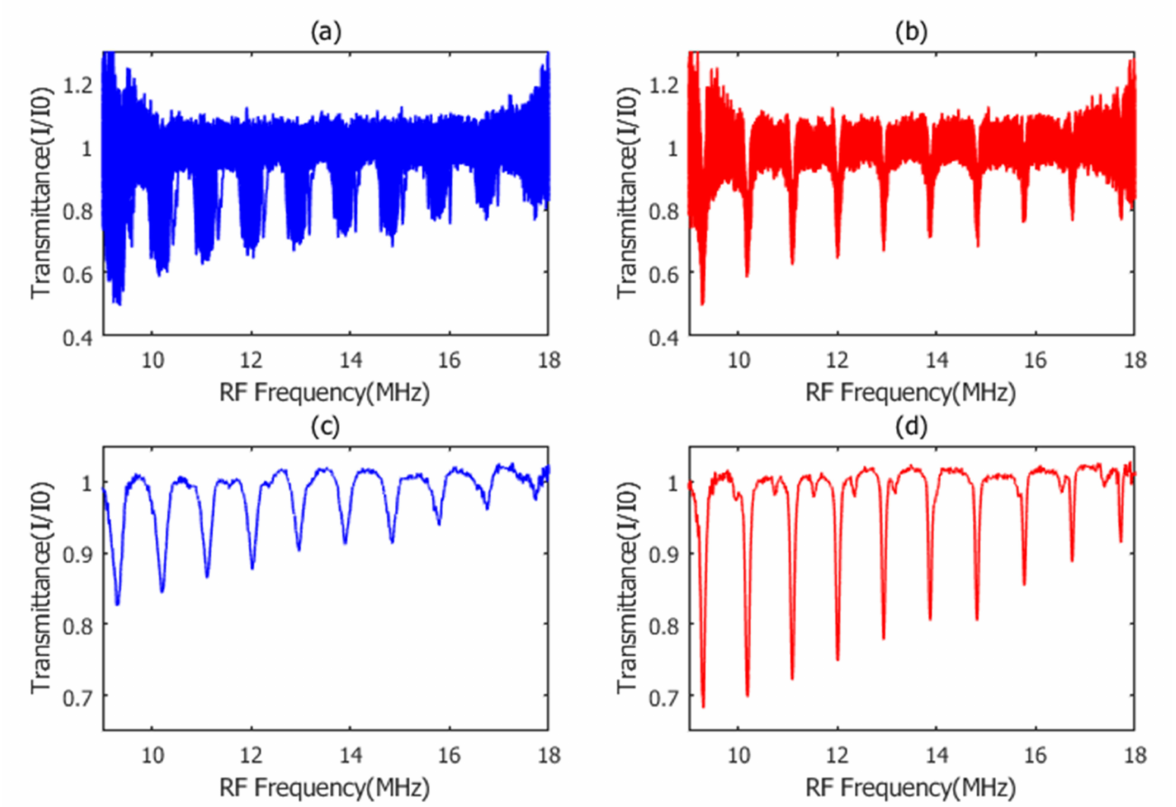
Figure 5. The effect of our periodic spectrum alignment method for 0.2 s transmittance averaging. The baseline has been normalized by fitting. ( a ) Raw transmittance spectra of 100 different IGMs frames; ( b ) aligned transmittance spectra of 100 different IGMs frames; ( c ) averaged raw transmittance spectra of 100 different IGMs frames, the relative center frequency drift between them prominently broadens the linewidth and distort the lineshape; and ( d ) averaged transmittance spectra of 100 aligned IGMs frames by periodic spectrum alignment